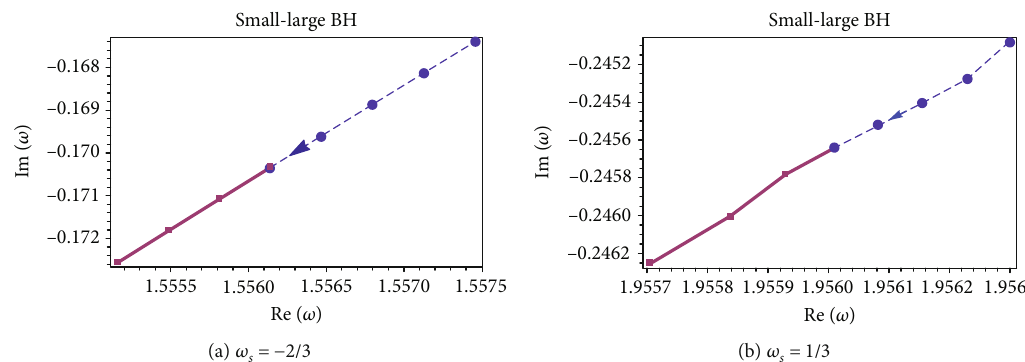
= 1/3 . The arrow denotes the increase in r s